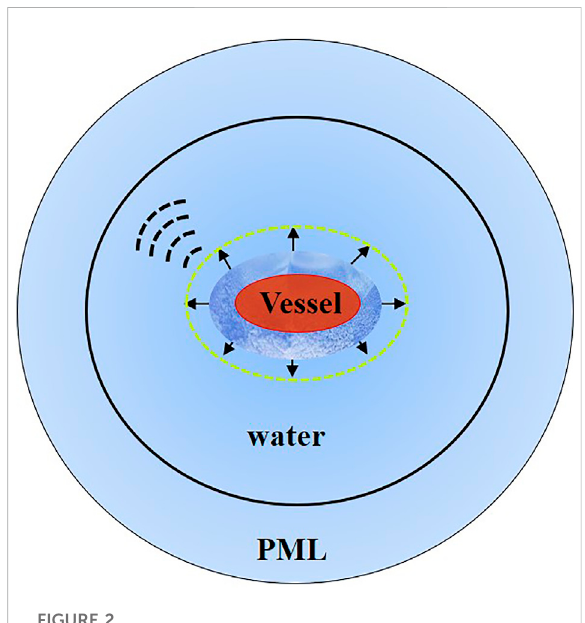
Schematic of the two-dimensional cross section model of the fl uidic elliptic cylinder for fi nite element modelling (FEM) simulation of photoacoustic waves. The small arrows denote the thermal expansion due to both fl uidic elliptic cylinder and adjacent thin layer of water treated as the elastic solid. The photoacoustic pressure is simulated in the surrounding